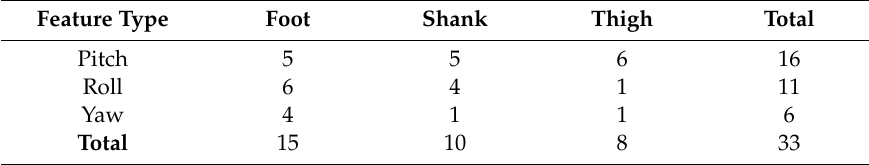
Table 4. The features selected by wrapper techniques using the random forest algorithm.